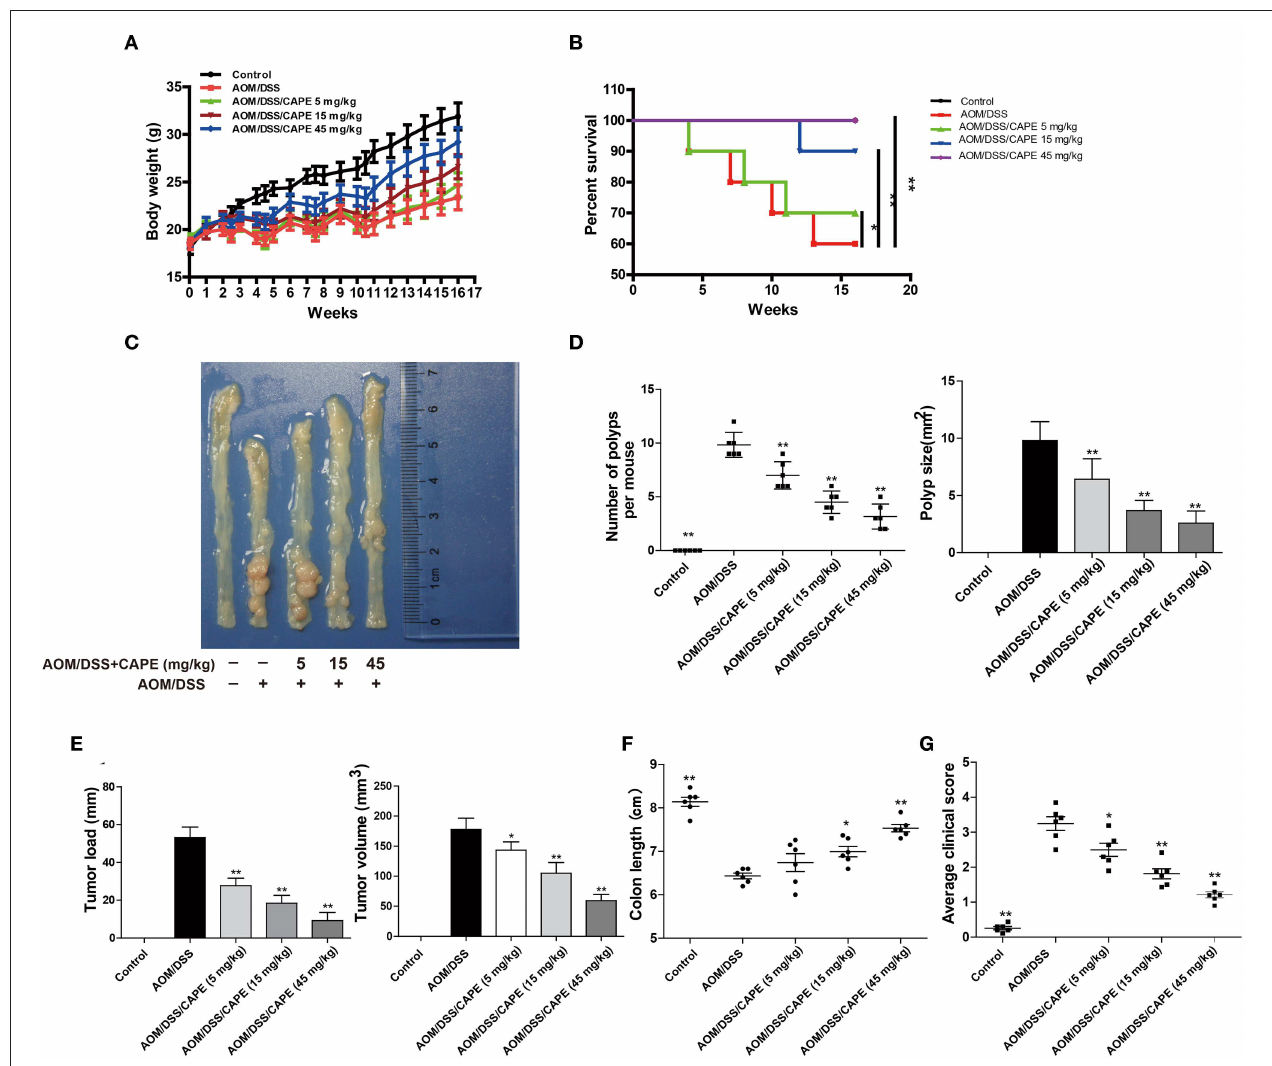
FIGURE 4 | CAPE alleviates mouse colitis progression and tumor burden resulting from AOM/DSS treatment. (A – G) Effect of CAPE on (A) body weight, (B) survival rate, (C) intestinal tract (representative image), (D) number of polyps and polyp size, (E) tumor load and tumor size, (F) colon length and (G) average clinical score. Data are presented as mean ± SD ( n = 3). * P < 0.05, ** P < 0.01 vs. AOM/DSS